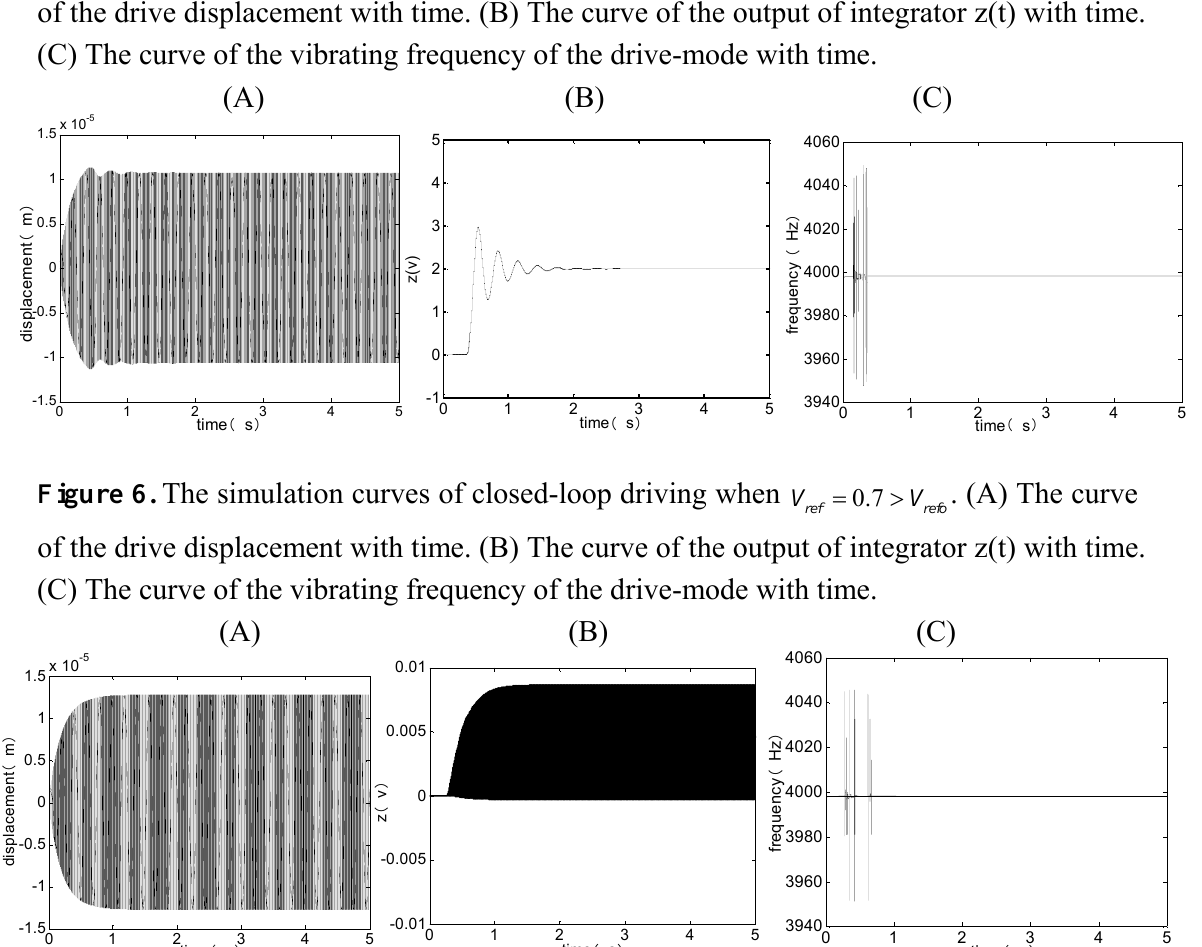
V V   . (A) The curve ref refo